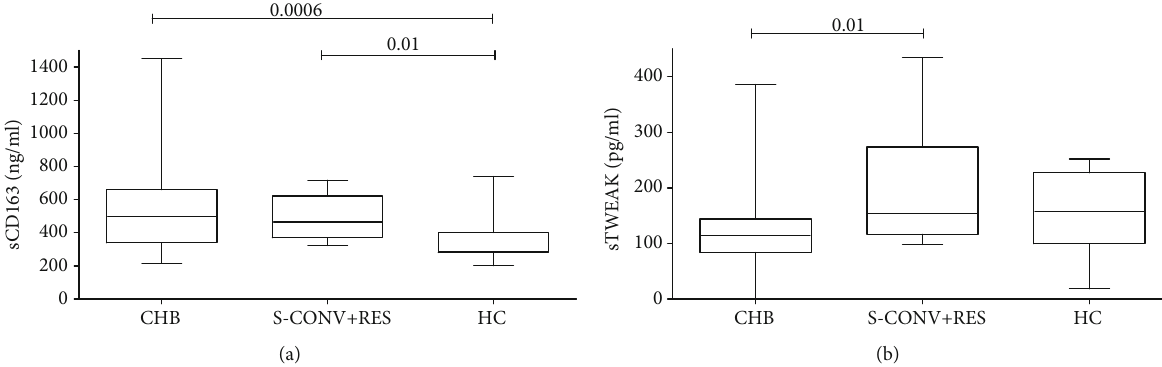
Figure 5: sCD163 and sTWEAK levels in plasma. (a) Plasma concentration of sCD163 in CHB, S-CONV+RES, and HC groups. (b) Plasma concentration of sTWEAK in CHB, S-CONV+RES, and HC groups. Data presented as median values with 25 th and 75 th percentile and minimum-maximum values. Table 3: Correlations between sCD163/sTWEAK and CD163 expression (MFI) on monocyte subpopulations.